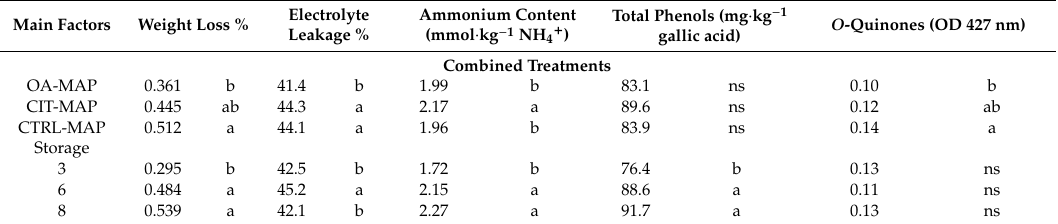
Table 2. Main e ff ects of main factors (combined treatments or storage) on the postharvest quality of fresh-cut iceberg